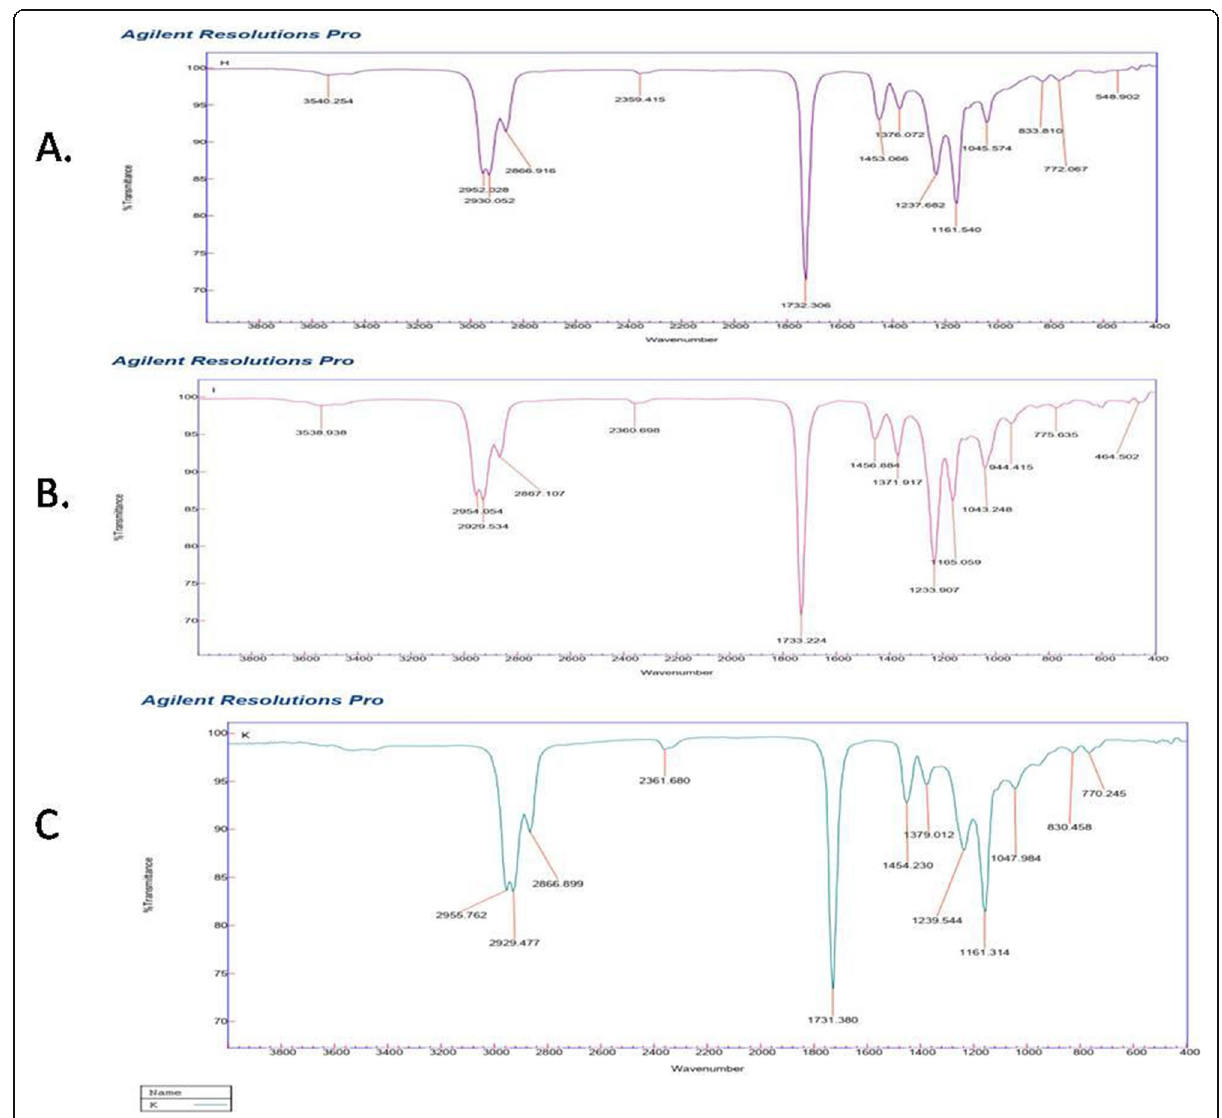
Fig. 6 ATR spectra of DIA patch at A 0 months, B 6 months under room temperature, and C 6 months under storage